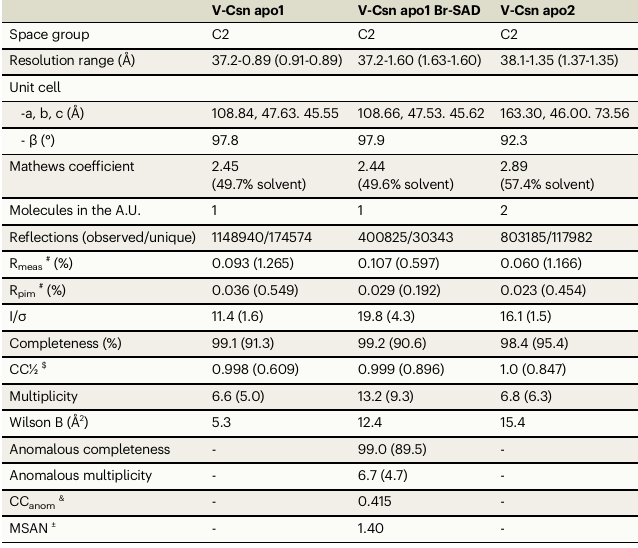
* Numbers in parenthesesrelateto the highest resolution shell. # R meas istheredundancy- independentmerging R factorandR pim isthe precision-indicating mergingR factor 71 . $ Percen- tage ofcorrelationbetween intensitiesfrom random half-sets ofdata 72 . & Correlation of Δ I anom fromtwo random half-sets 73 . ± MSANis themid-slopeof theanomalousnormalprobabilityplot. Values >1 indicate signi fi cantanomalous signal 73 .